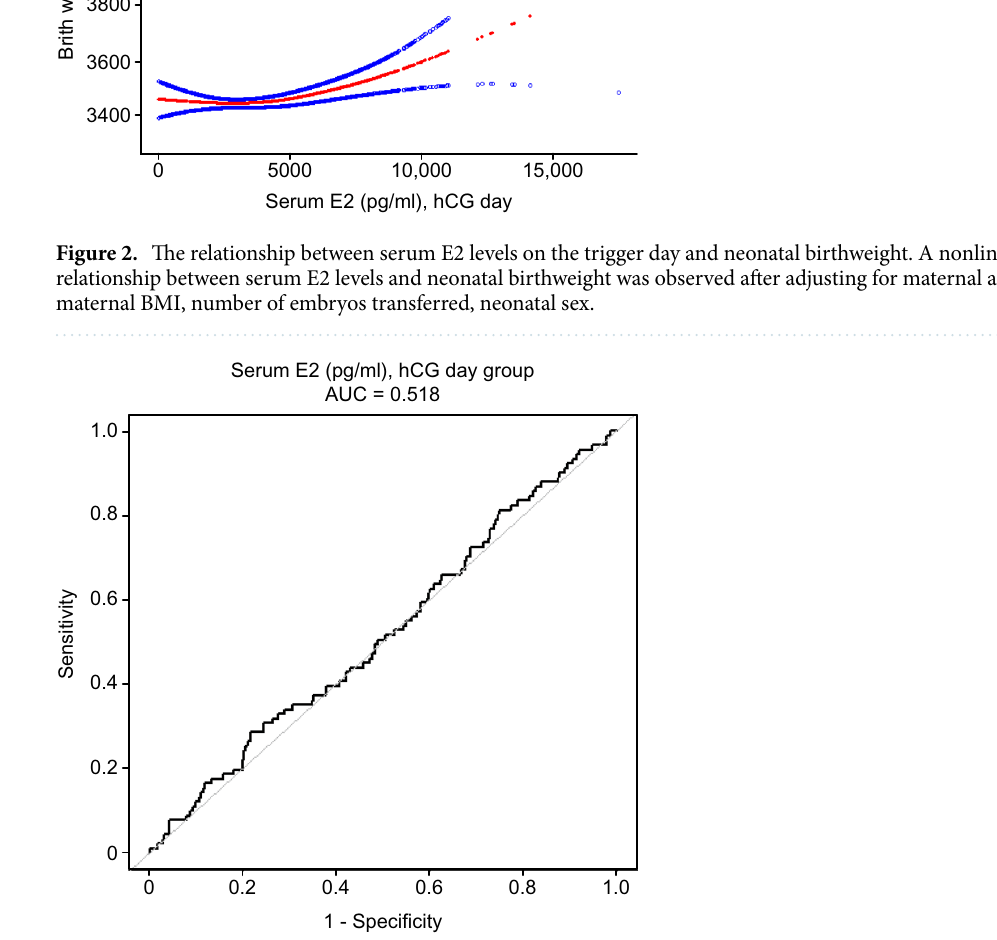
Figure 3. Receiver operating characteristic (ROC) curve evaluation of the ability of peak E2 measurements to predict low birth weight. The best threshold is 2062 pg/ml with a sensitivity of 28.6%, a specificity of 78.1%, and an area under the curve of